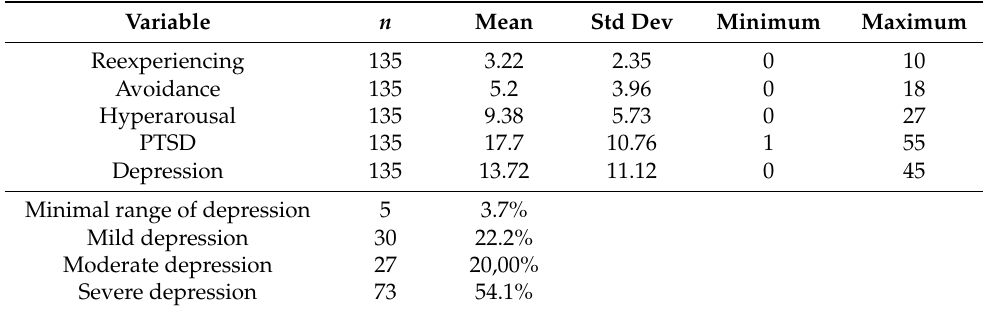
Table 2. Psychological adjustment at Time 1.